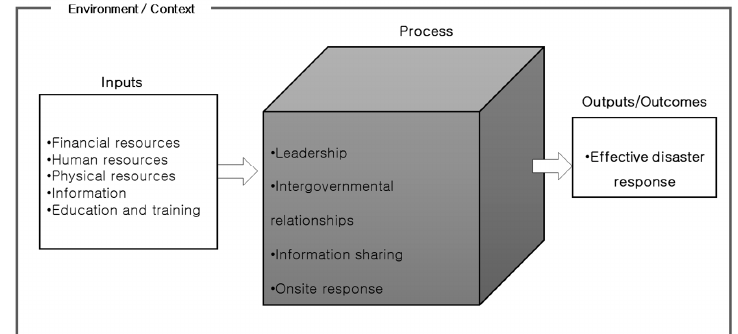
Figure 2. Categorization of the factors influencing disaster response.